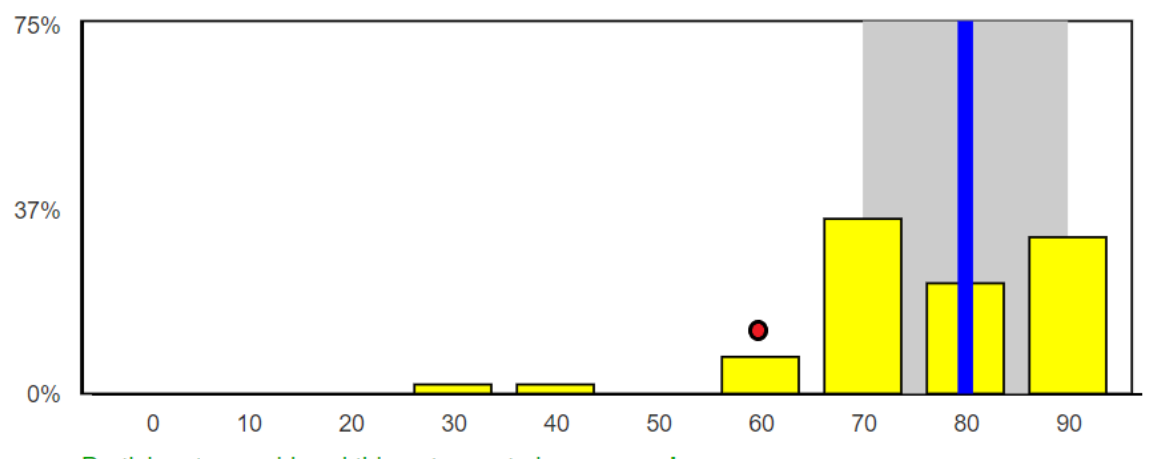
Figure 2. Mock-up of Round 2 graphic. The frequency of the 10 intervals of the entire panel’s ratings will be shown in yellow bars along with the group median (blue line), and the panelist’s own response (red